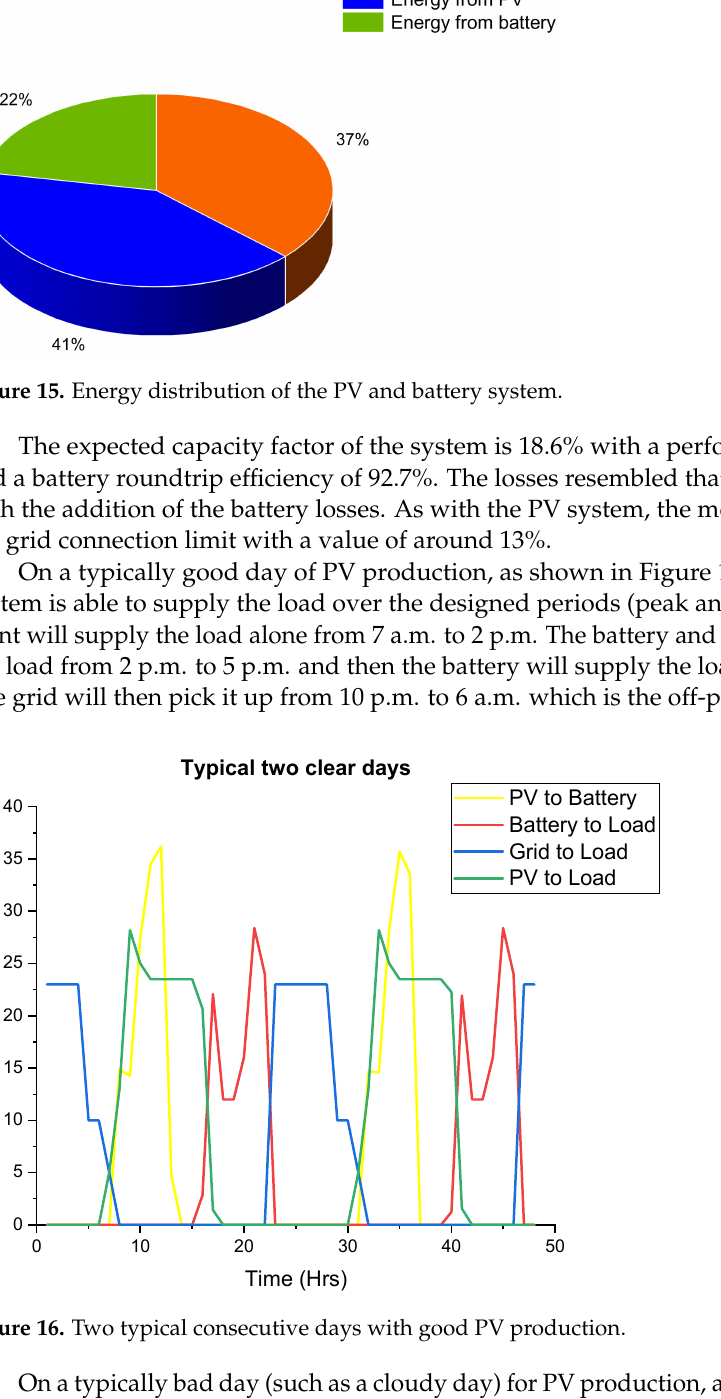
Typical two cloudy days